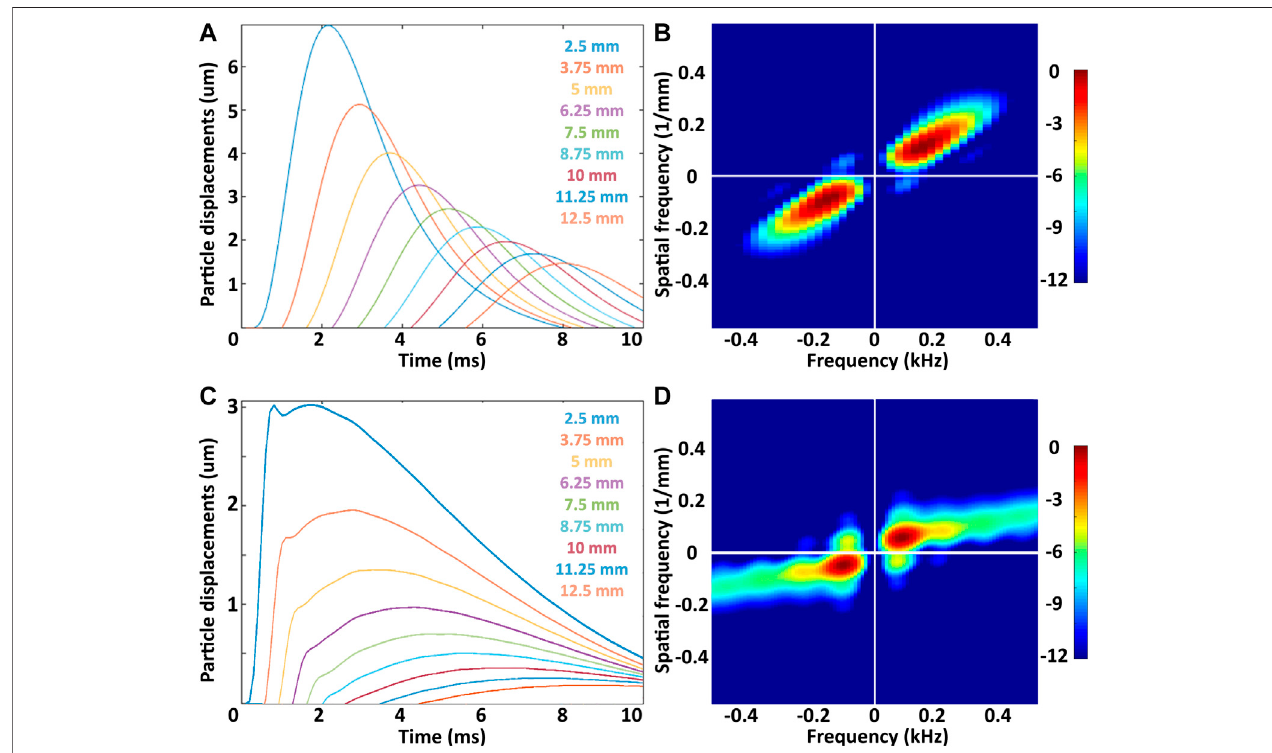
FIGURE1|(A) and (C) Particledisplacementsasafunctionoftimeinducedinthesimulatedviscoelasticmediawith0.6and6 Pa sviscosity,respectively.Labelsindicate the distance from the center of the ARF stimulus. (B) y (D) Fourier spectra for the same media. The spectrum peak occurs within a frequency range from 100 to 200 Hz.